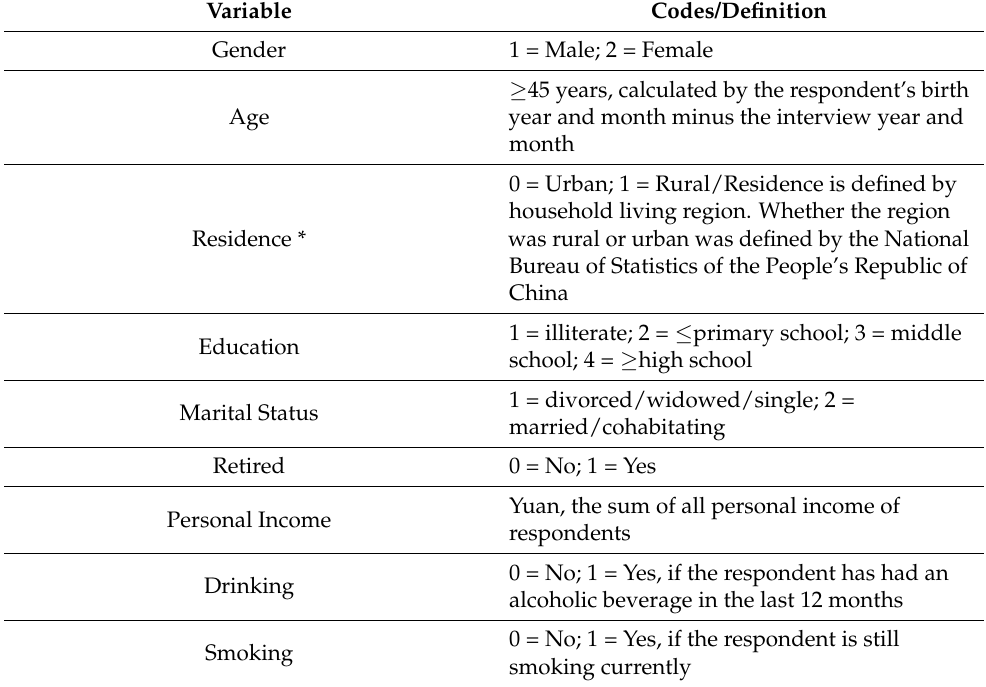
Table 2. Codes/definition of the control